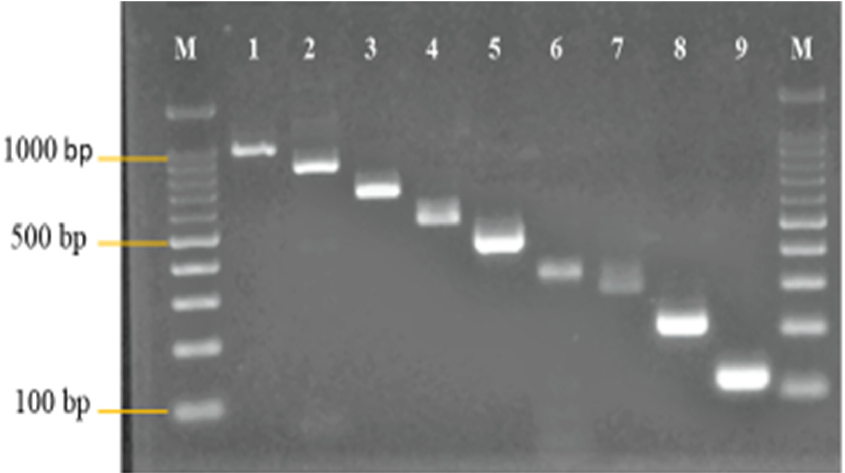
Figure 1. Monoplex PCR of 16S rRNA Enterococcus , ctxA (IAC), vancomycin and linezolid resistant genes primers. The differences in the sizes of the primers ranged from 50–150 bp. The designed primers were all amplified at their expected sizes. Lanes M: DNA ladder 100 bp plus. Lane 1: 16S rRNA Enterococcus (990 bp). Lane 2 : vanA (850 bp). Lane 3: optrA (700 bp). Lane 4: cfr (550 bp). Lane